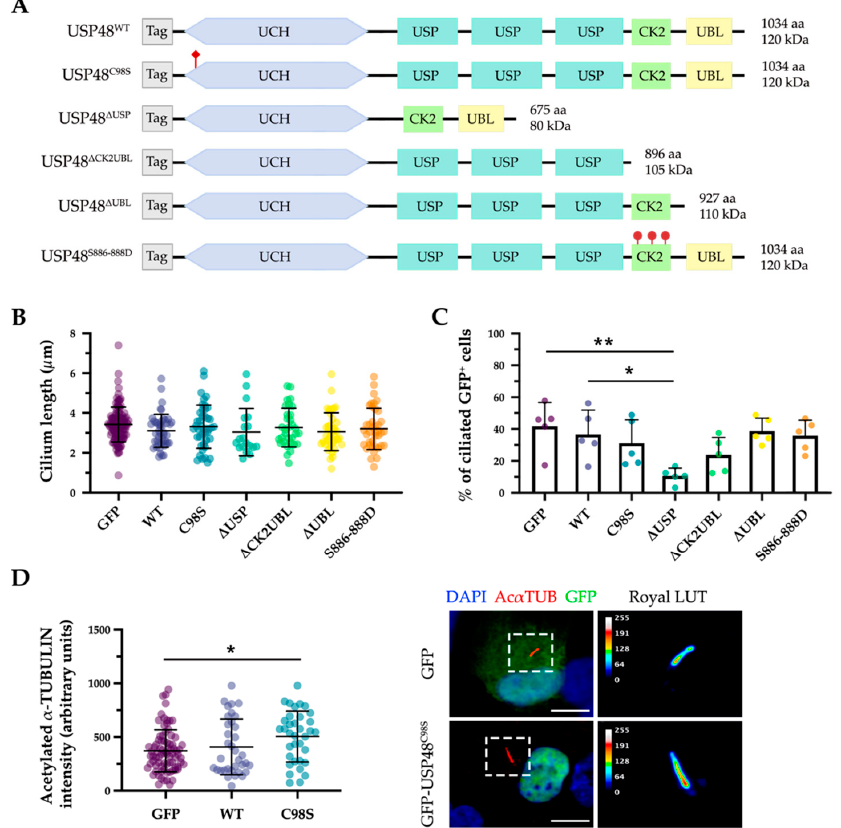
Figure 3. Overexpression of different USP48 mutants results in a mild ciliary phenotype in hTERT- RPE1 cells. ( A ) Schematic representation of the different USP48 mutant constructs used in this study, showing the displayed protein domains, introduced point mutations (rhomboid and round red tags), the amino acid length, and predicted molecular weight of the protein product (excluding the tag of the fusion protein). ( B ) Cilium length of serum-starved hTERT-RPE1 cells transfected with different GFP-USP48 constructs was measured, and an empty GFP vector used as control (one-way ANOVA test; n = 20–120; three independent replicates). ( C ) Percentage of ciliated GFP-positive cells was determined by randomly counting >50 cells from each condition, revealing a significant decrease in ciliogenesis when the GFP-USP48 ∆ USP mutant is overexpressed (Kruskal-Wallis test; * = p -value ≤ 0.05, ** = p -value ≤ 0.01; n = 5 independent experiments). ( D ) Quantification of the fluorescence intensity of acetylated α -tubulin in ciliated GFP-positive cells shows a statistically significant increase in cells overexpressing the catalytic mutant GFP-USP48 C98S (Kruskal-Wallis test; * = p -value ≤ 0.05; n = 35–80; three independent experiments). At the right, representative images of the cilium from hTERT-RPE1 cells transfected with GFP (control) and GFP-USP48 C98S showing the differences in the fluorescence intensity of acetylated α -tubulin using the ROYAL range of colours (the calibration bar from 0 to 255 grey values is depicted). Cells were immunostained with anti-acetylated α -tubulin (Ac α TUB, red) and anti-GFP (green), and nuclei were labelled with DAPI (blue). Data in all the graphics represent the mean ± SD. Scale bar: 10 µ m. UCH, ubiquitin C-terminal hydrolase domain; DUSP, domain in ubiquitin-specific protease; CK2, casein-kinase-2 phosphorylation domain; UBL, ubiquitin-like domain; LUT, lookup